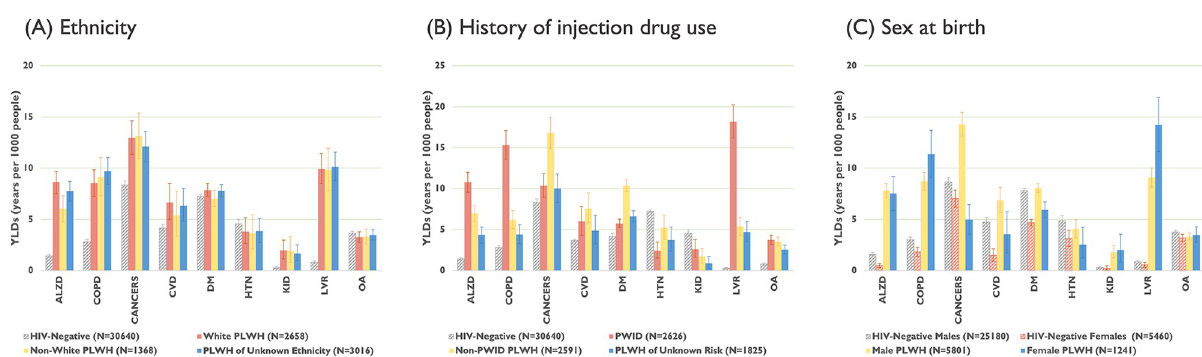
Fig 4. Cumulative YLDs (2008–2012) per 1000 people, with 95% credible intervals, associated with nine selected chronic comorbidities among people living with HIV in British Columbia, Canada, stratified by ethnicity (A), history of injection drug use (B) and sex at birth (C). Note: PLWH: people living with HIV; YLDs: years of healthy life lost due to disability; PWID: PLWH who have ever injected drugs; ALZD: Alzheimer’s and/or non-HIV- related dementia; CANCERS: non-AIDS-defining cancers; COPD: chronic obstructive pulmonary disease; CVD: cardiovascular diseases; DM: diabetes mellitus; HTN: hypertension; KID: kidney diseases; LVR: liver diseases; OA: osteoarthritis. Vertical scales differ for each graph for illustration purposes.